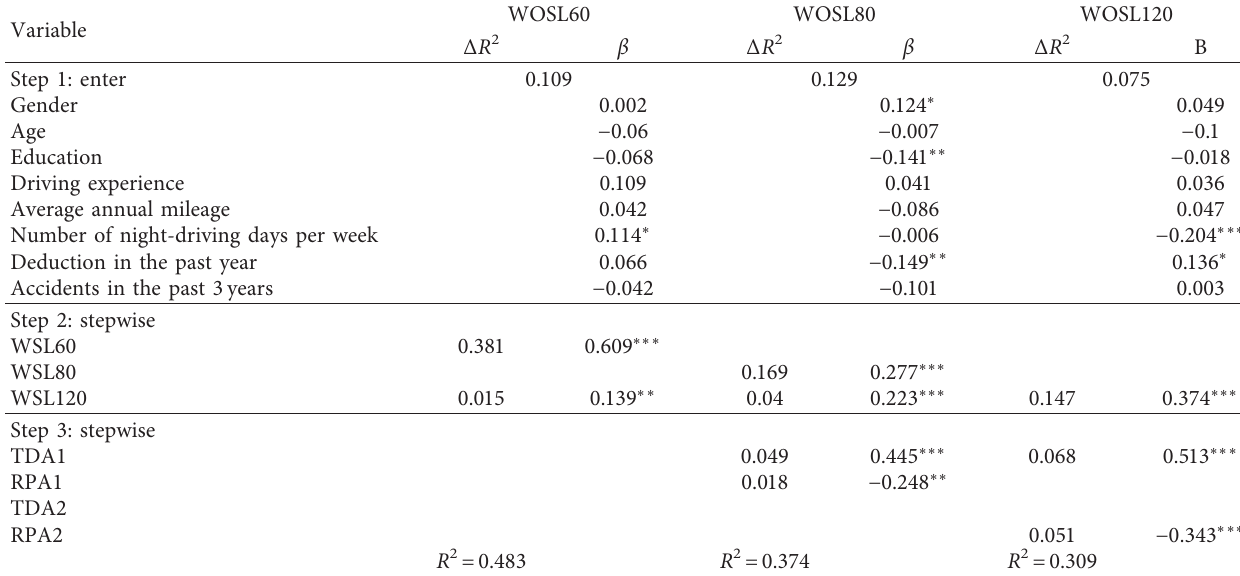
Table 5: Regression prediction model of speed selection behaviour in low